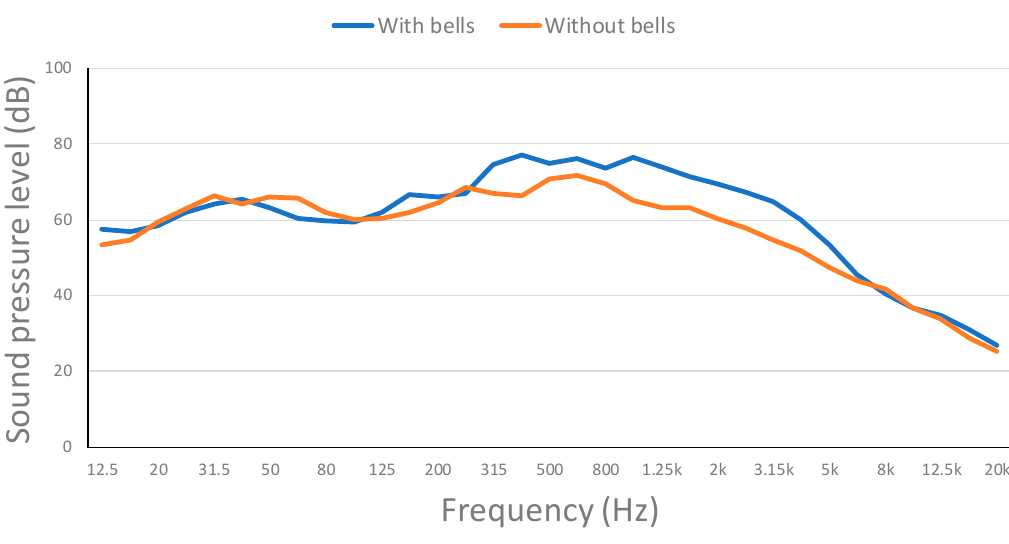
Figure 13. Evolution of the continuous sound pressure level for each frequency band in outside point 3.